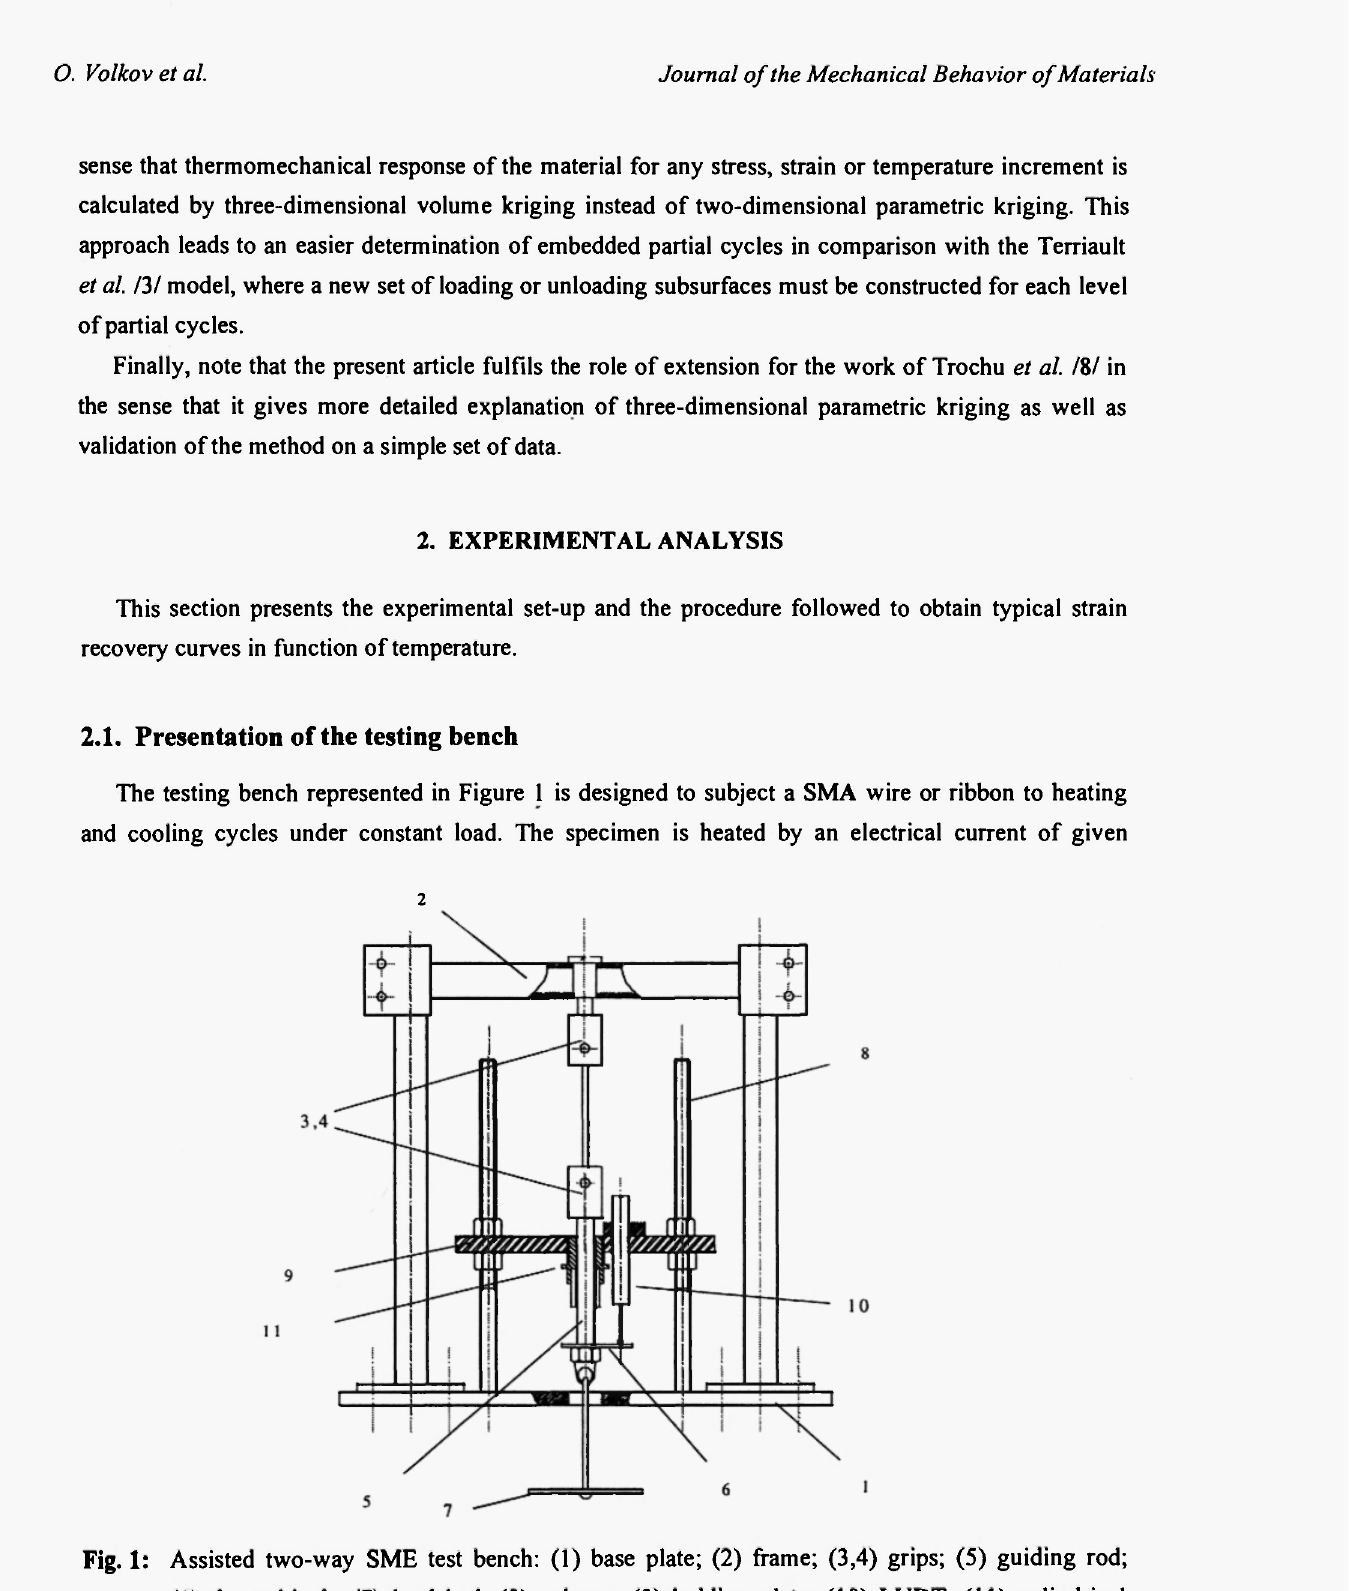
Fig. 1: Assisted two-way SME test bench: (1) base plate; (2) frame; (3,4) grips; (5) guiding rod; (6) thrust block; (7) load bed; (8) column; (9) holding plate; (10) LVDT; (11) cylindrical sliding